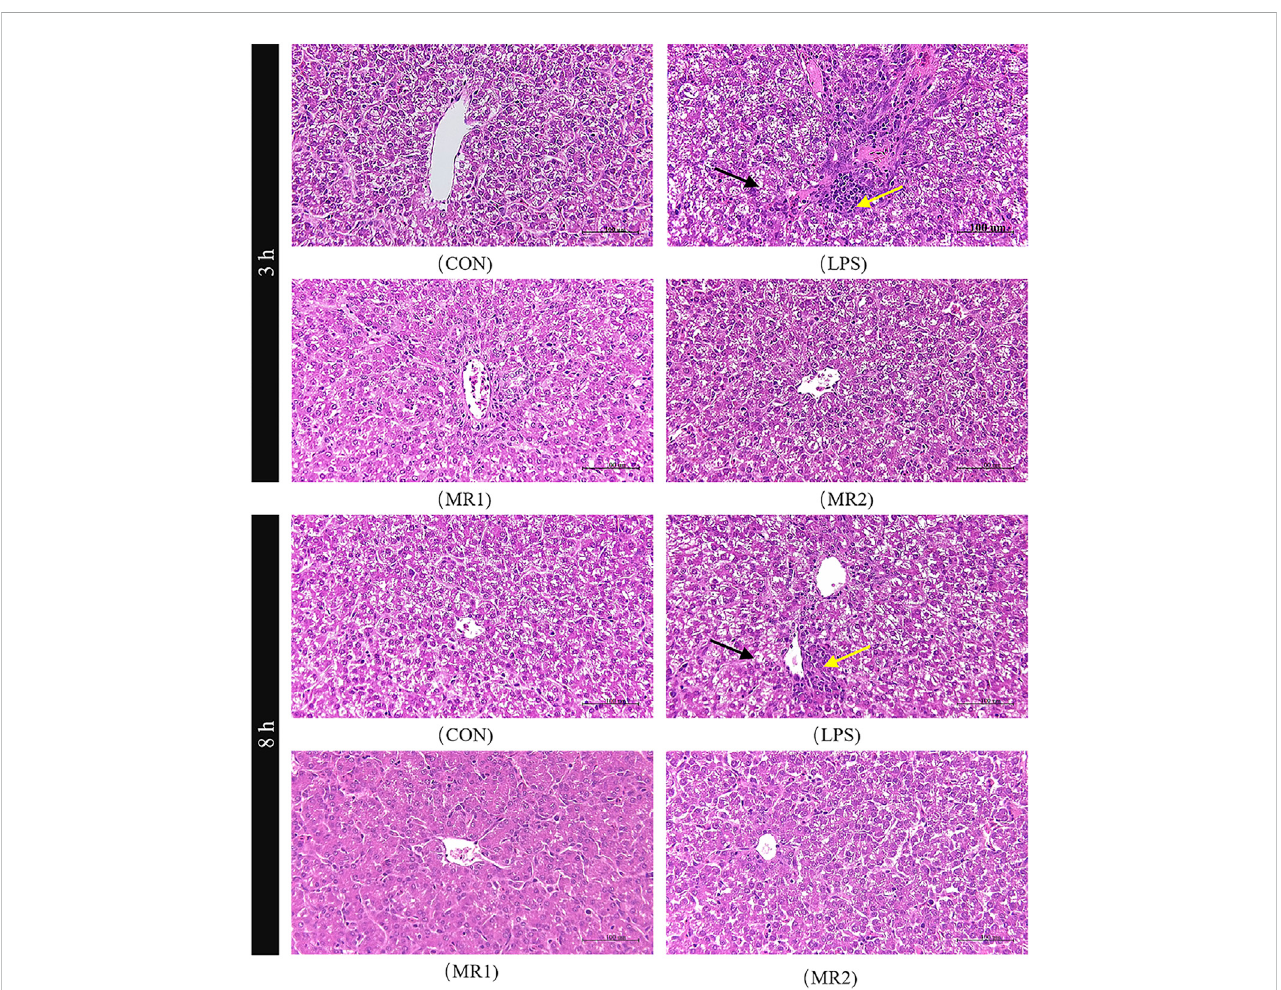
FIGURE 1 Effects of methionine restriction on histopathological analysis of liver in broilers stimulated by LPS (H and E staining, 400 ×). The yellow arrows point to in fl ammatory cells and the red scissors point to the vacuolar degeneration. CON, a basal diet plus intraperitoneal administration of sterile saline; LPS, a basal diet plus intraperitoneal administration of LPS; MR1, 0.3% mehtionine restriction diet plus intraperitoneal administration of LPS; MR2, 0.4% mehtionine restriction diet in combination with intraperitoneal administration of LPS. 3 h, 3 h after LPS stimulation; 8 h, 8 h after LPS stimulation.